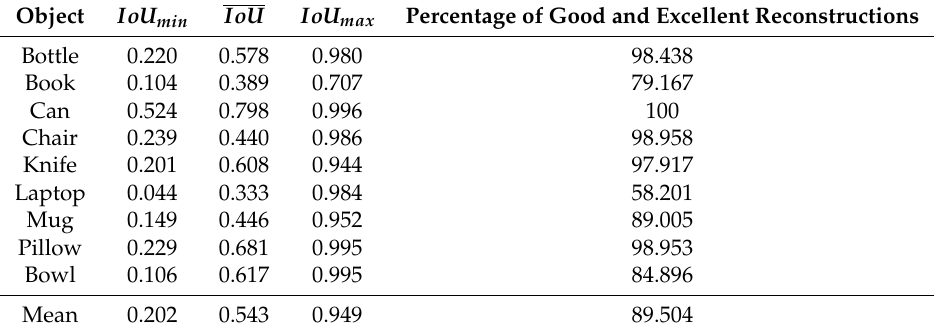
Table 2. Comparison of qualitative reconstruction comparison between prediction and ground truths using the IoU metric, and the number of different objects in training set.